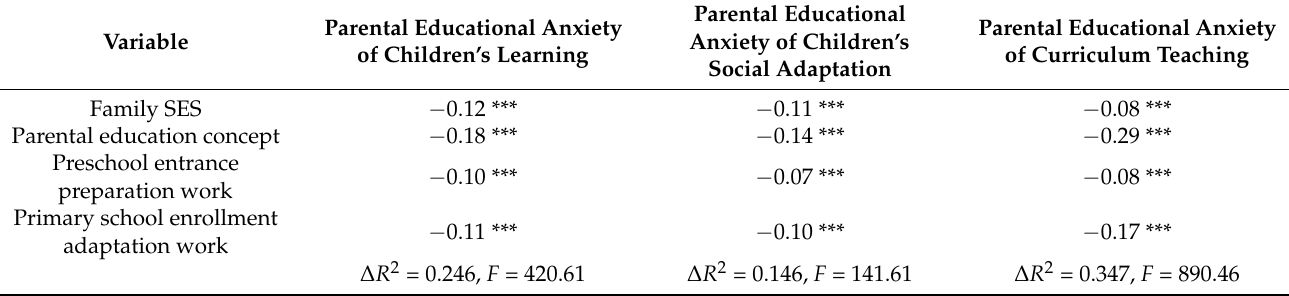
Table 3. Factors influencing parental educational